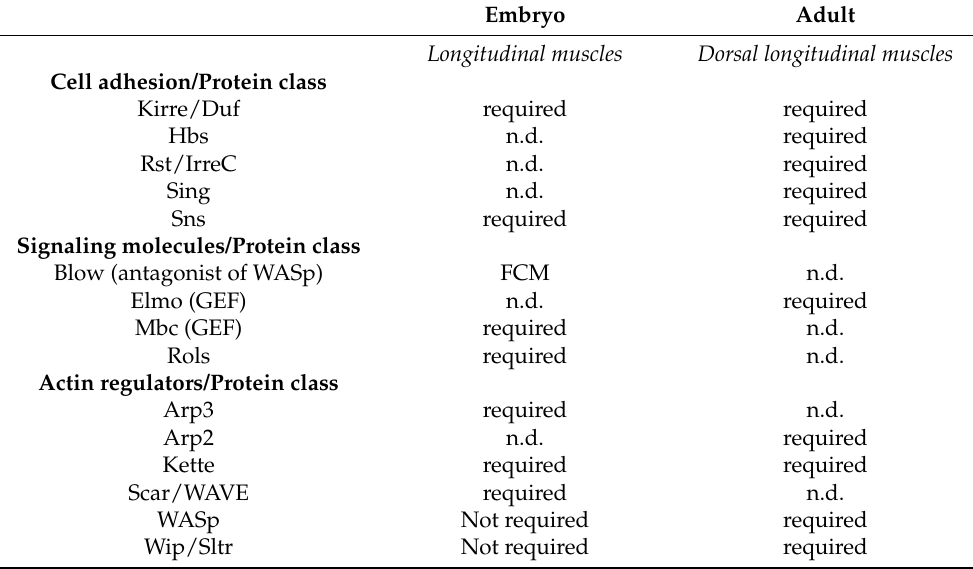
Table 1. List of proteins that are important for somatic myoblast fusion and play a role in longitu- dinal and/or DLM flight muscle formation.